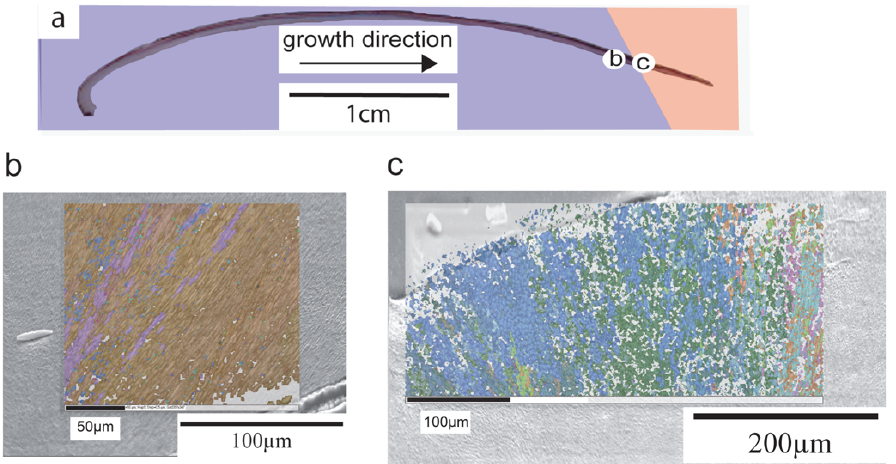
Fig. 5. Thin-section view of M. galloprovincialis from experimental site B1. (a) Blue colour indicates shell precipitated prior to transplanta- tion and red colour indicates shell precipitated after transplantation to acidified experimental site. ( b and c ) Electron backscattered diffraction (EBSD) maps. Note location of b and c in Fig. 5a. Different colours indicate different orientations of calcite prisms. White points denote those regions within the shell where Kikuchi patterns could not be indexed. The three RGB colour components code for the three Euler angles of crystal orientation. In order to visualize all patterns the whole range of Euler angles are plotted (Euler 1 between 0–180 ◦ , Euler 2 between 0–180 ◦ and Euler 3 between 0–120 ◦ ). Note rather homogenous (brown to lilac, b ) colours in well structured calcite shell prior to transplantation. The EBSD map of shell portions precipitated after the transplantation indicates a wider range of colours and spatially disorganized calcite prisms indicating shell precipitation under acidified